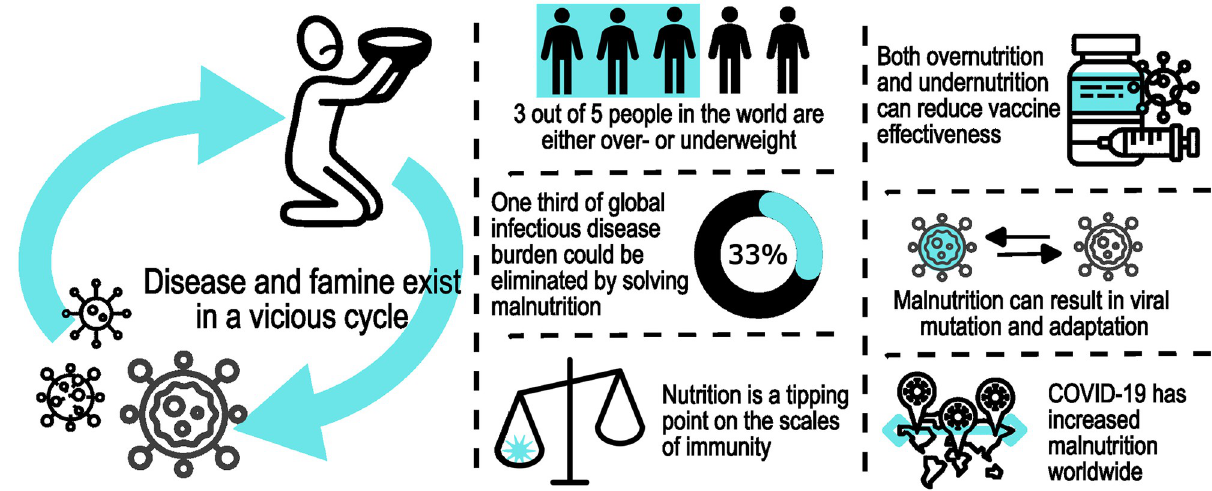
Fig 1. Some key facts and points on the vicious cycle of nutrition and infectious disease. Nutrition is critical for immune response and protection from infection. A significant proportion of people in the world are malnourished, a major concern for infectious disease. COVID-19 has increased malnutrition worldwide, creating conditions that may lead to the next pandemic. “People pack” by Dumitriu Robert, “Coronavirus pack” by Graphic Mall, “Coronavirus icon pack” by SkyClick, and “Coronavirus COVID-19 pack” by Eucalyp Studio are all available at http://www.iconfinder.com